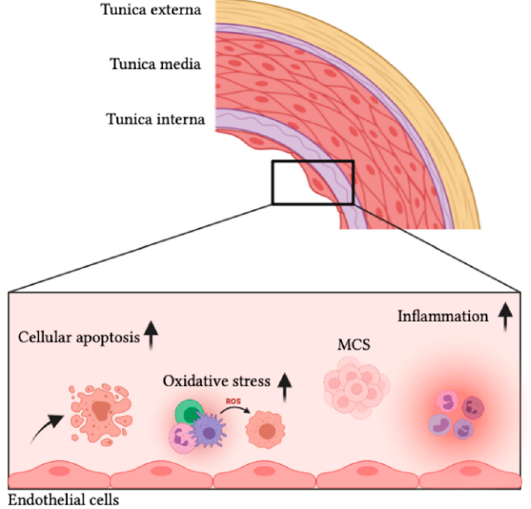
Figure 4. The endothelial cell response to microgravity. Multicellular spheroids (MCS); reactive oxygen species (ROS); increase (↑ ).